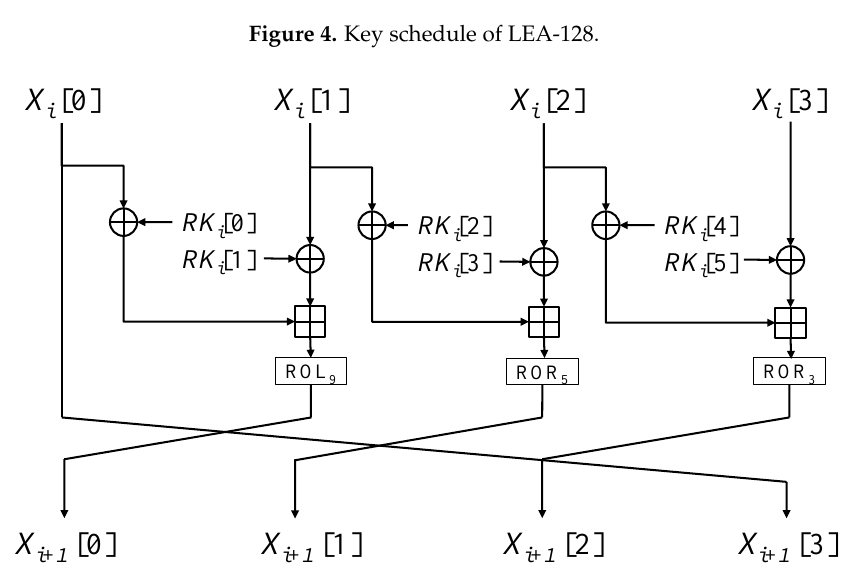
Figure 4. Key schedule of LEA-128.